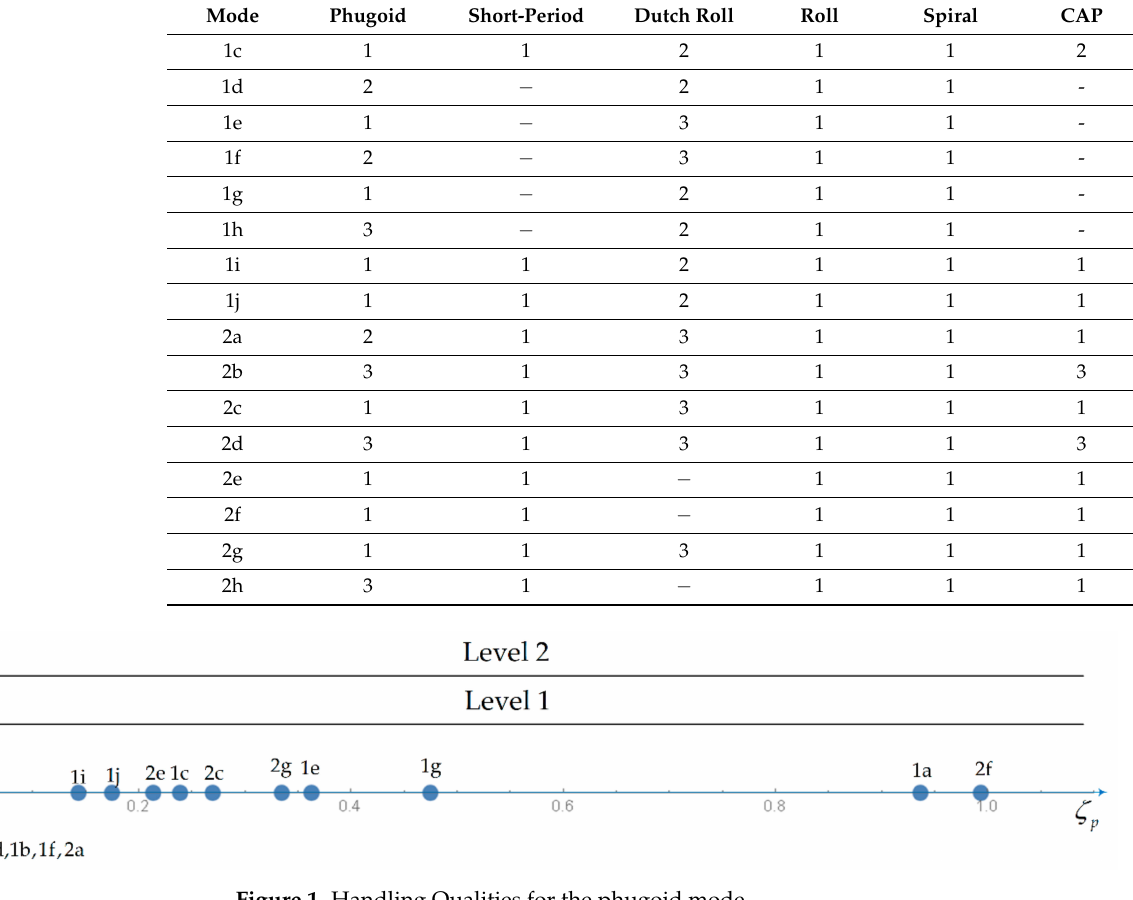
Figure 1. Handling Qualities for the phugoid mode.